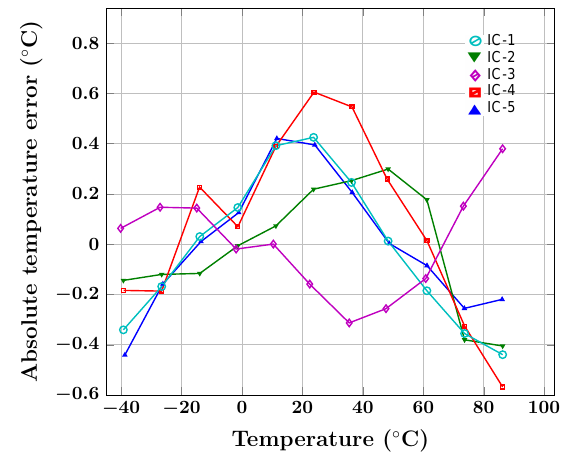
Figure 10. Measured absolute temperature error of differential